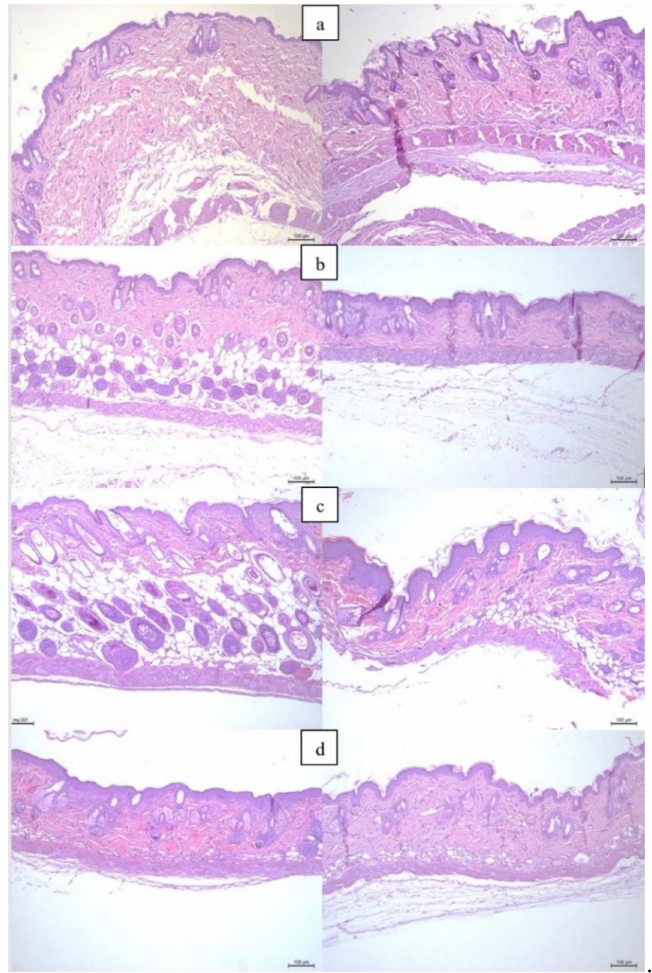
Figure 2. Histological examination of the skin of ICR mice from the photoaging group ( left ) and the control group ( right ): at the beginning of the experiment (without irradiation) ( a ), and after 5 ( b ), 10 ( c ), and 12 ( d ) weeks of the experiment. Hematoxylin and eosin staining, ×